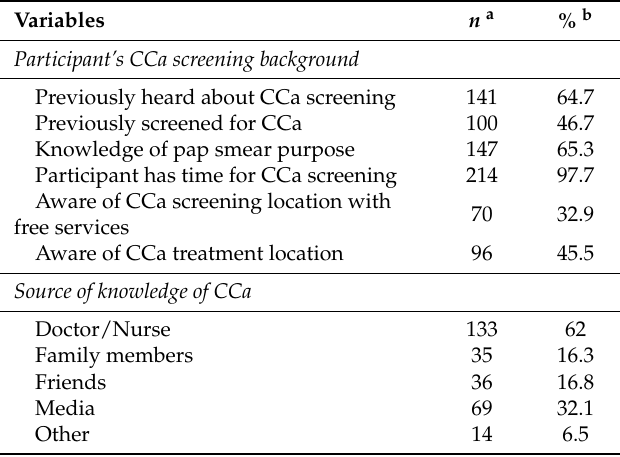
Table 2. Previous cervical cancer screening experience.